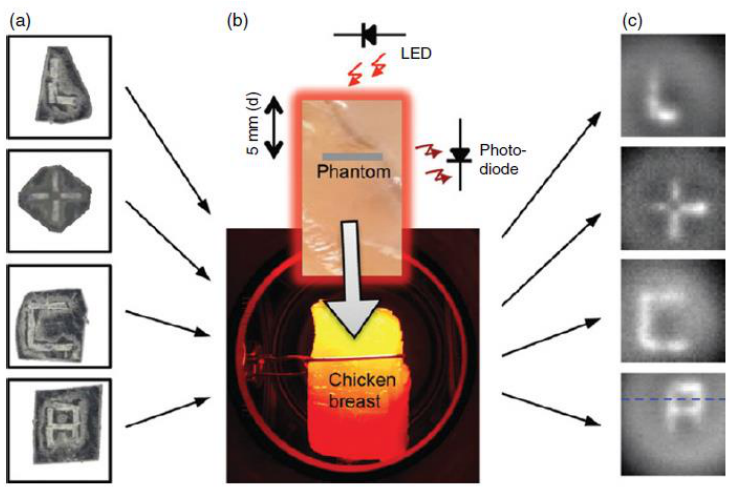
Figure 14. Panel ( a ) ND phantoms made of commercial NDs. ( b ) Chicken breast illuminated by an LED. The stripe on the chicken breast marks the edge of the phantom, which is placed within the chicken breast, 5 mm behind the front surface, facing the LED emitting at 621 nm. Fluorescence is collected out to the side. ( c ) ND phantoms imaged outside of the chicken breast. Reprinted with permission from [86]. Reproduced with permission of the American Chemical Society, 2013.